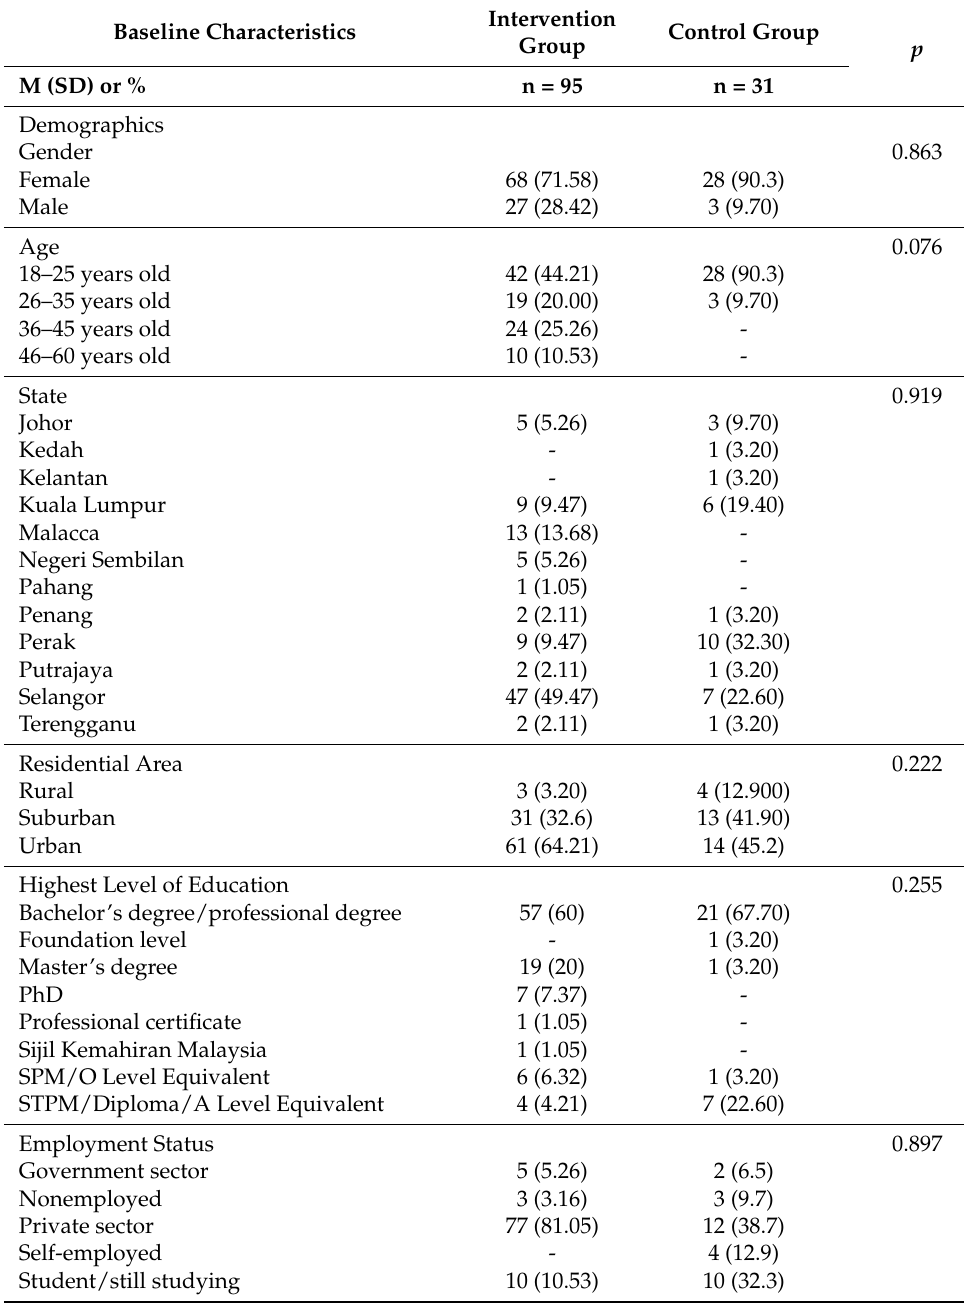
Table 2. Baseline Characteristics of The